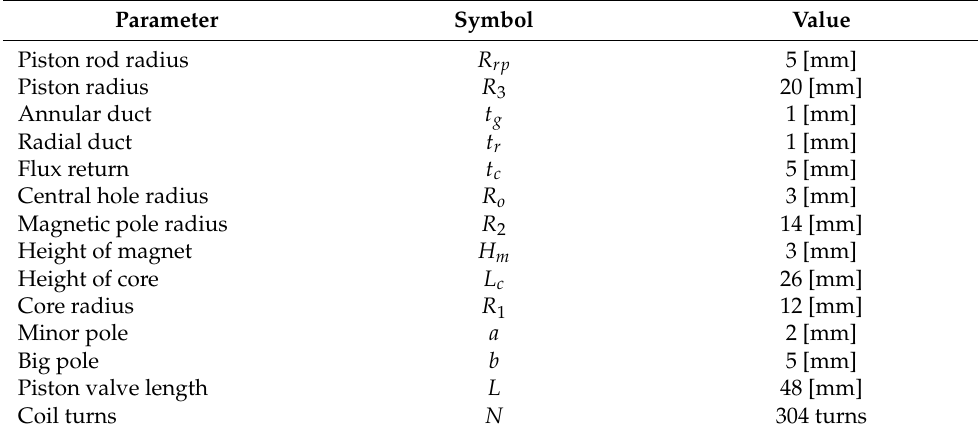
Figure 1. Schematic diagram of the proposed HARMRD. Table 1. Structural dimensions of the proposed HARMRD.